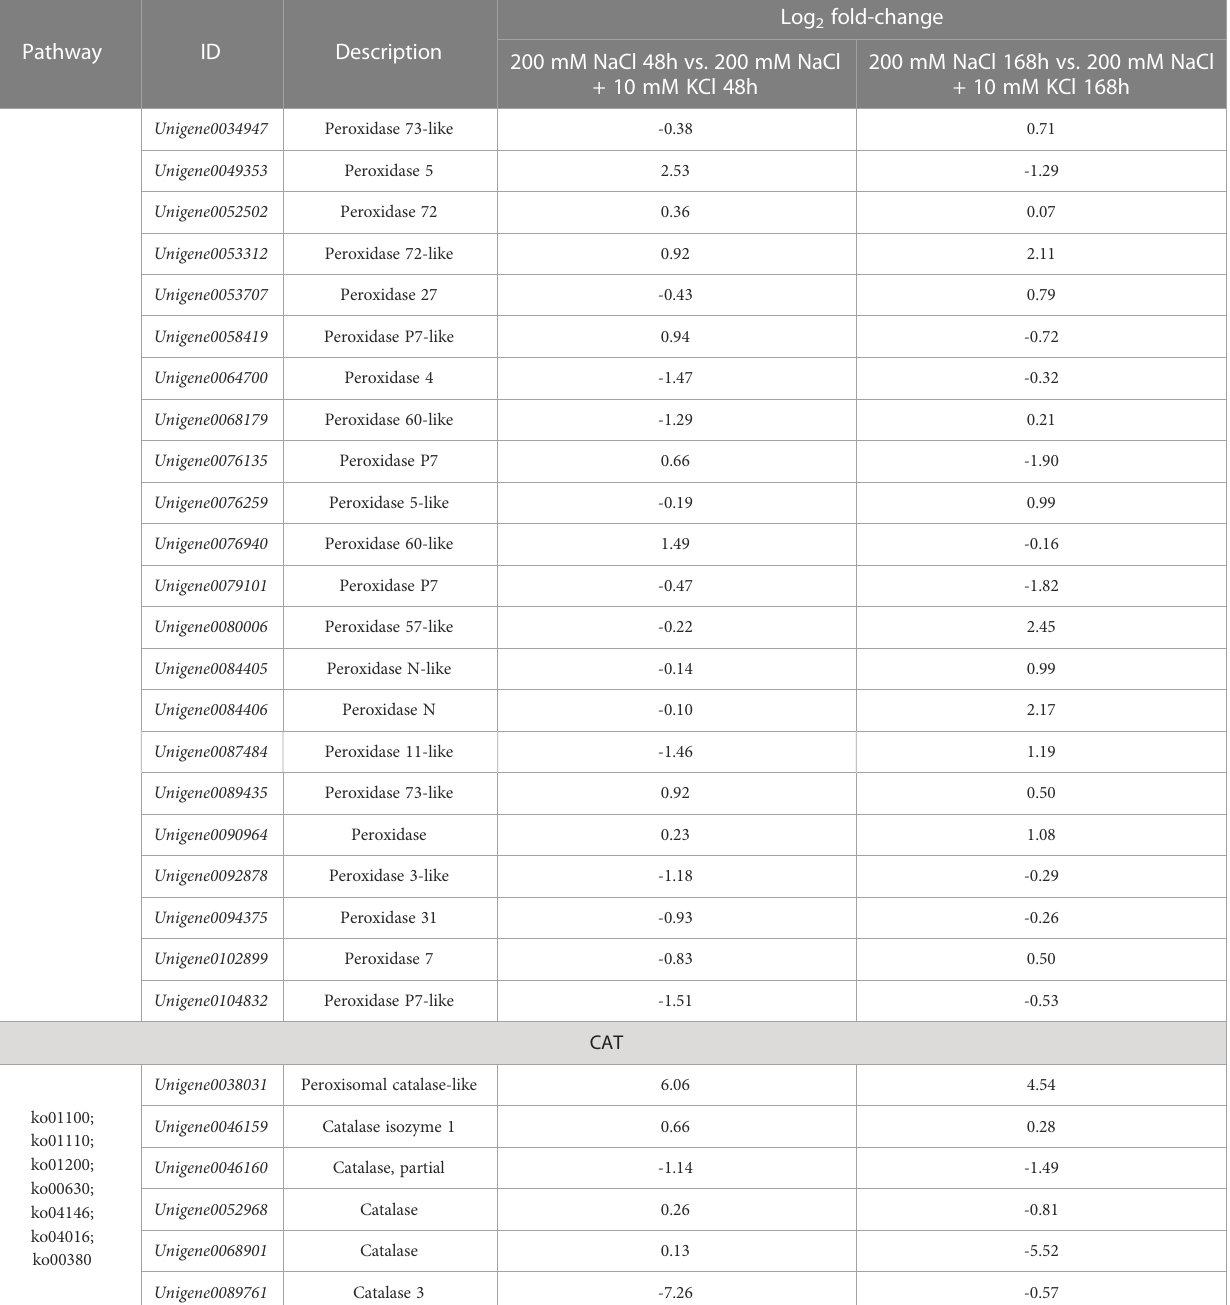
activity of SOD (Supplementary Figure S1), 24 DEGs and 139 metabolites in the activity of POD (Supplementary Figure S2), and 2 DEGs and 17 metabolites in the activity of CAT (Supplementary Figure S3) were in line with the absolute correlation coef fi cient of Person requirement for values |Corr|>0.8 and p < 0.05. As a result, the DEGs in SOD, POD and CAT activities are mainly positively correlated with metabolites. It indicated that the primary antioxidant enzyme activity mechanism of T . ramosissima was dominated by the positive regulation of DEGs and